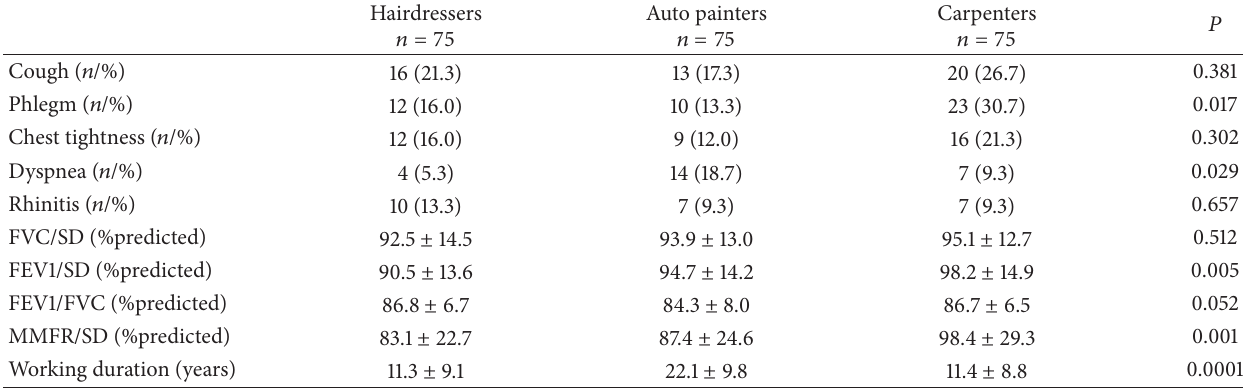
Table 1: Respiratory symptoms and respiratory function tests of